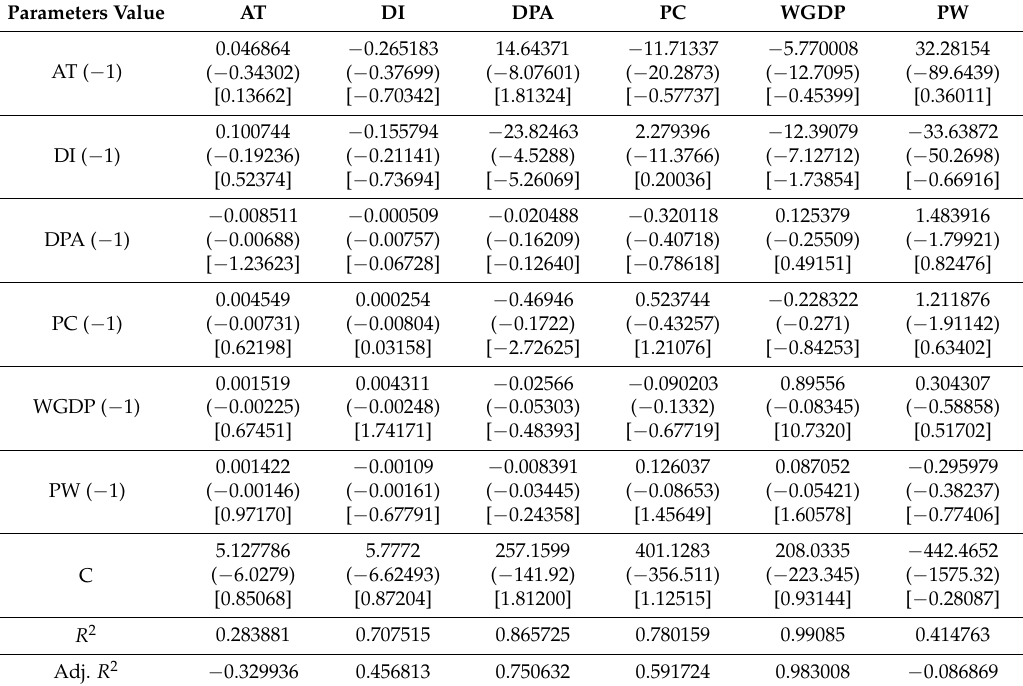
Table 7. VAR model parameters estimated value